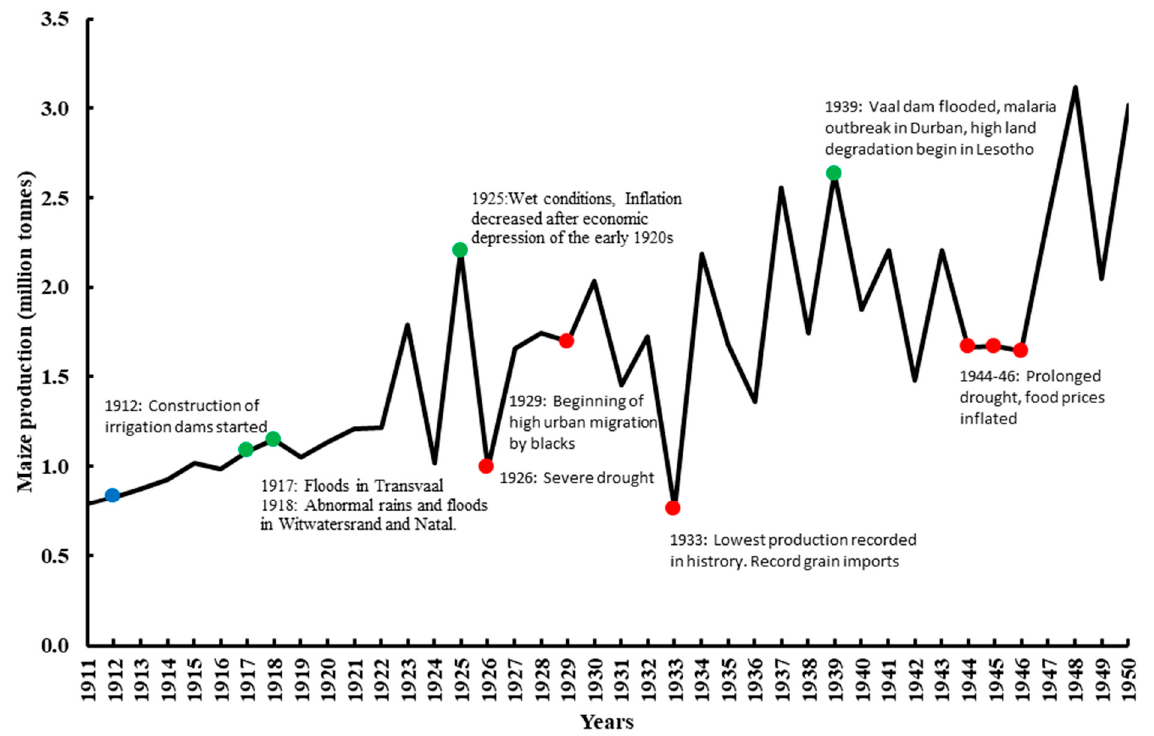
Figure 2. Historical maize production trends in South Africa (Data source: [86]).